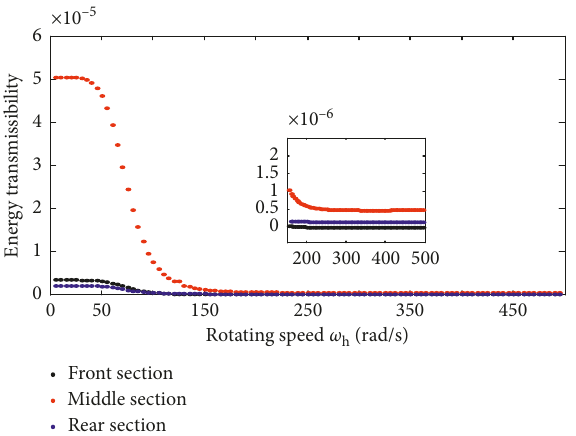
Figure 5: Energy transmissibility η with varying rotating speed of high-pressure rotor ω h : front section (black), middle section (red), and rear section (blue).